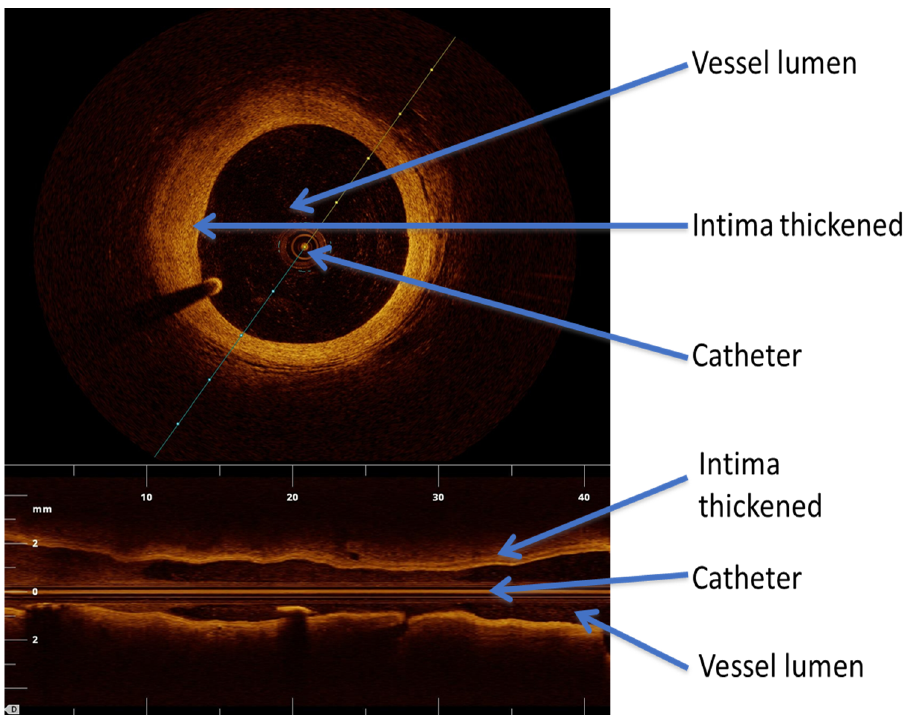
Figure 9. OCT images of a cross-sectional and longitudinal view of a coronary vessel. (This figure is adapted from reference: [72]. An open access journal.